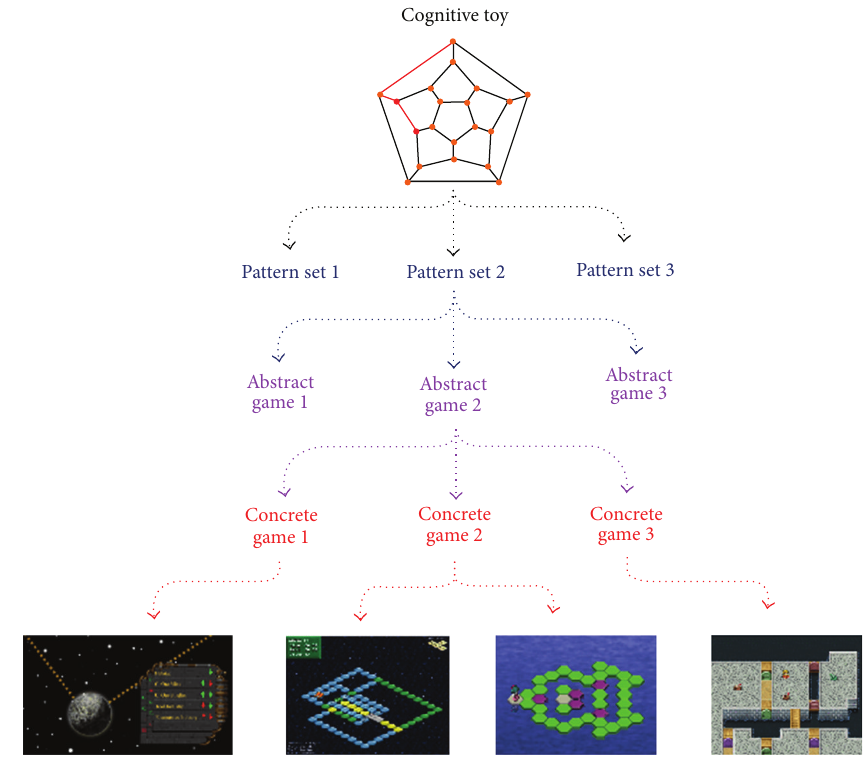
Figure 1: An example of the design process discussed in [20] being used to create four isomorphic computer games.